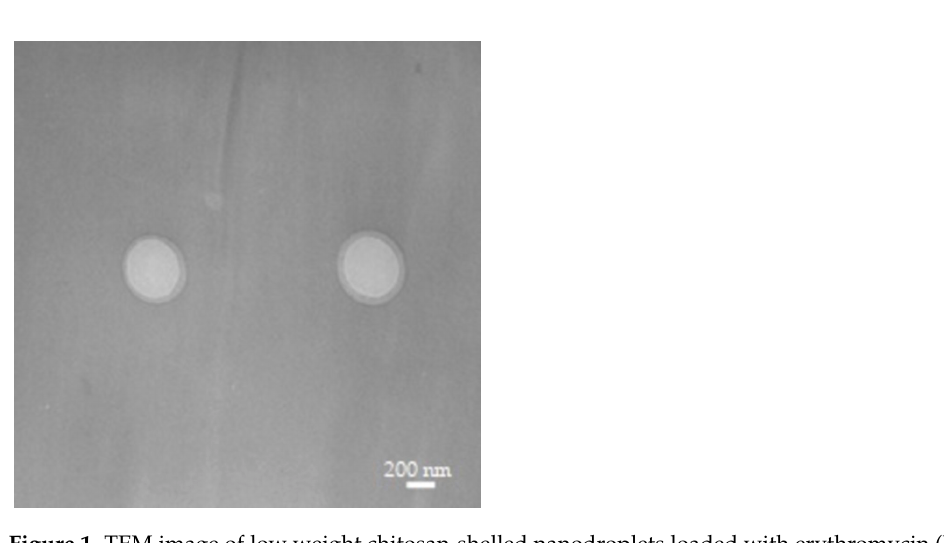
Figure 1. TEM image of low weight chitosan-shelled nanodroplets loaded with erythromycin (Magnification 28,500×).